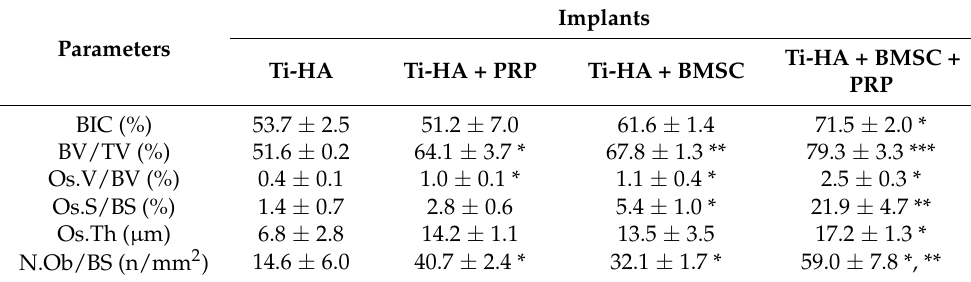
Table 2. Histomorphometric data 2 weeks after surgery (median ± SD).